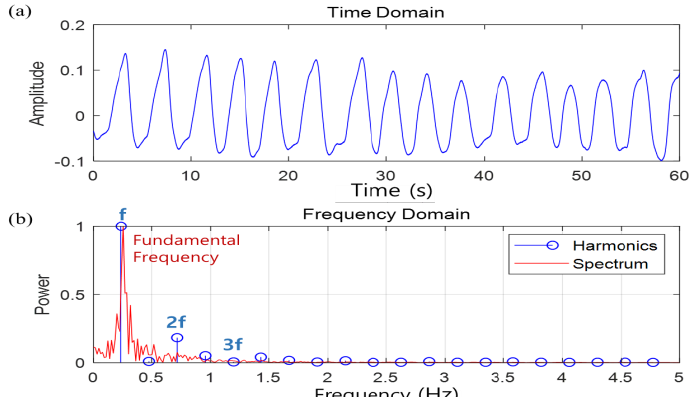
Figure 2. Harmonic component of the respiration signal: ( a ) time domain of respiration and ( b ) frequency domain of respiration.